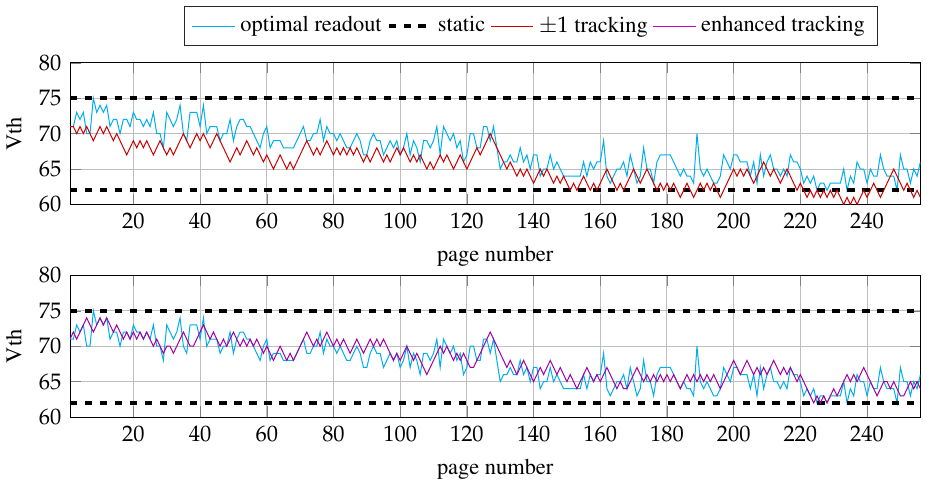
Figure 12. Threshold voltage adaptation of a TLC-Block on reference r 3 (55h bake, 3000 P/E).